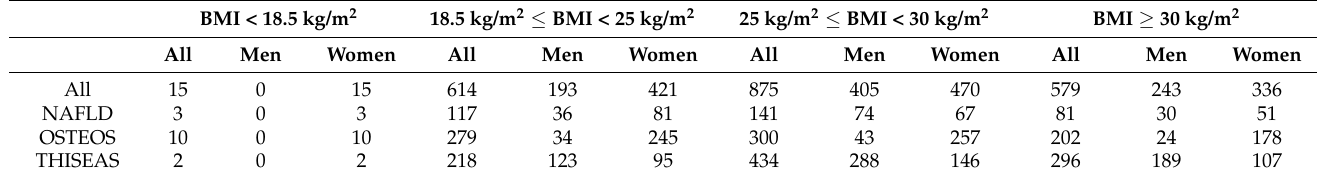
Table 2. Frequencies of BMI categories across the three